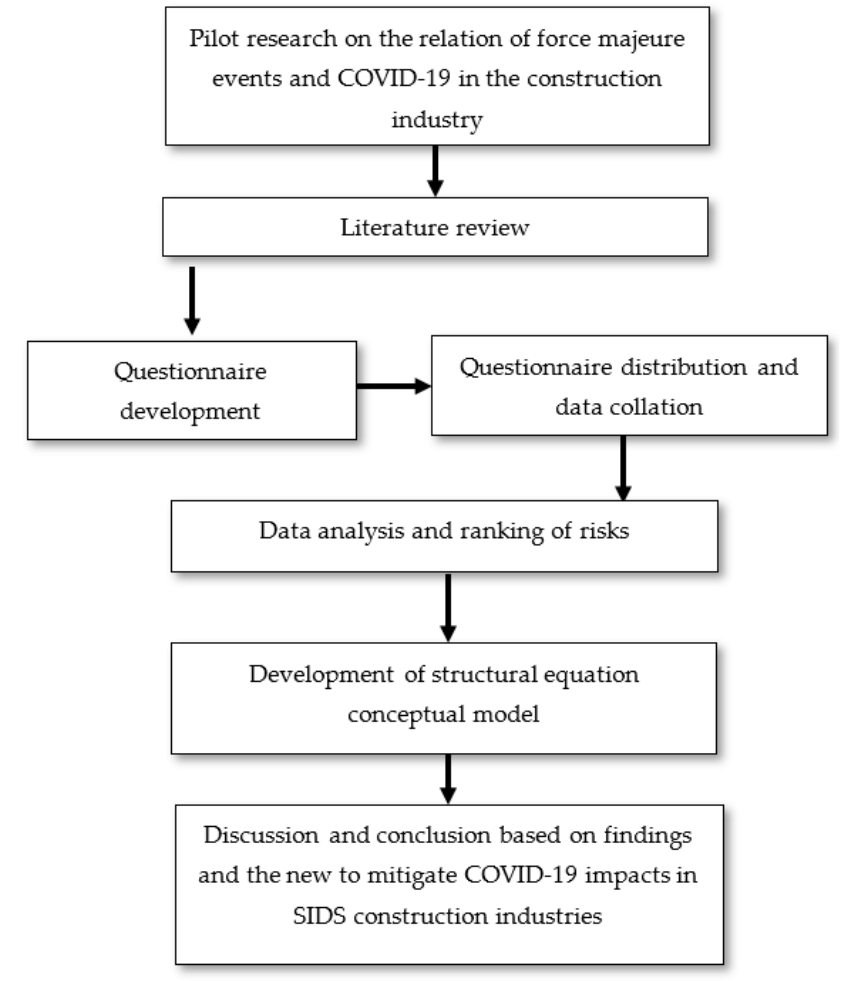
Figure 1. Work flow of the study.